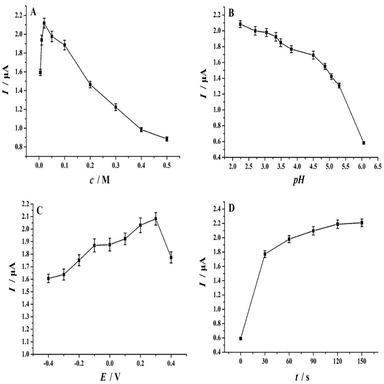
The optimum of experimental conditions: (A) the effect of H3PO4 concentration, (B) the effect of solution pH, (C) the effect of accumulation potential and (D) the effect of accumulation time on the peak current of 10 µM Trp at the Ni NPs/N-C/CPE. Scan rate: 0.1 V s − 1 .